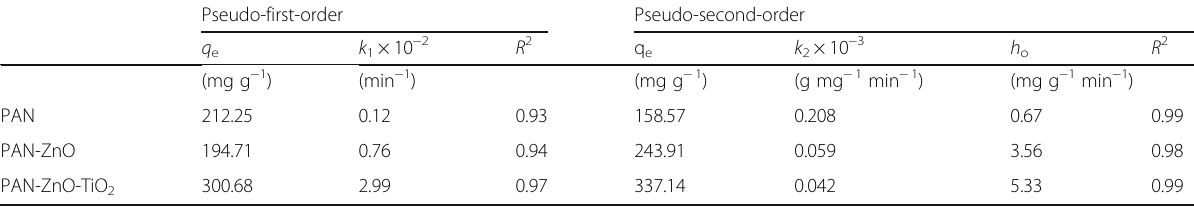
Table 3 Kinetic parameters of Cr (VI) adsorption onto the nanoparticle decorated PAN based n- fib@Mats